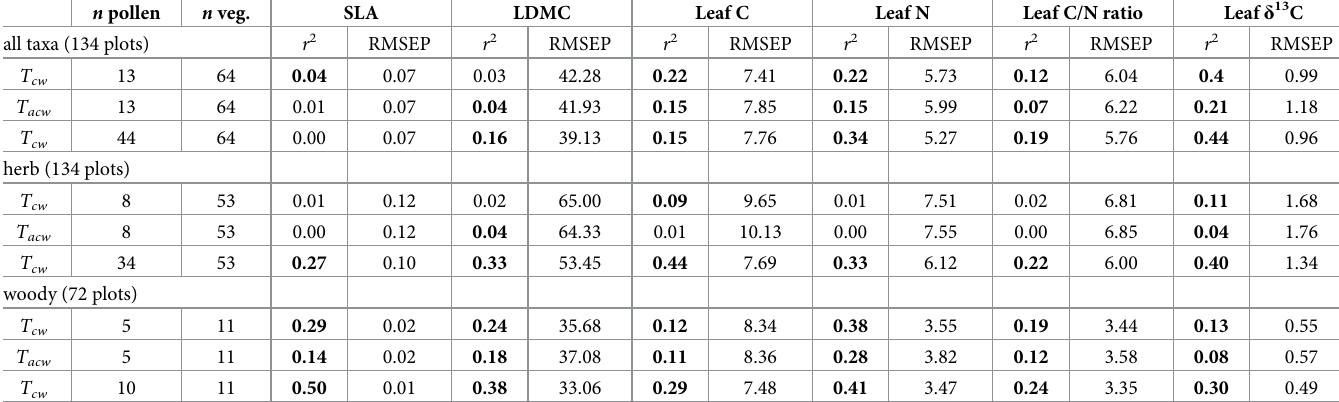
also originate from beyond the sampled plot, and as a result the pollen signal from the within- plot vegetation will be ‘diluted’. There may also be some reduction of variability caused by the averaging of trait values to characterise taxa with indistinguishable pollen, especially for Table 1. r 2 and RMSEP (root mean square error of prediction) values of the linear relationship between modern pollen and vegetation. n pollen and n veg columns refer to the number of pollen types and vegetation species used in the analysis with count-weighted ( T cw ) and adjusted count-weighted traits ( T acw ). r 2 values in bold are significant at p < 0.05. SLA = specific leaf area; LDMC = leaf dry-matter